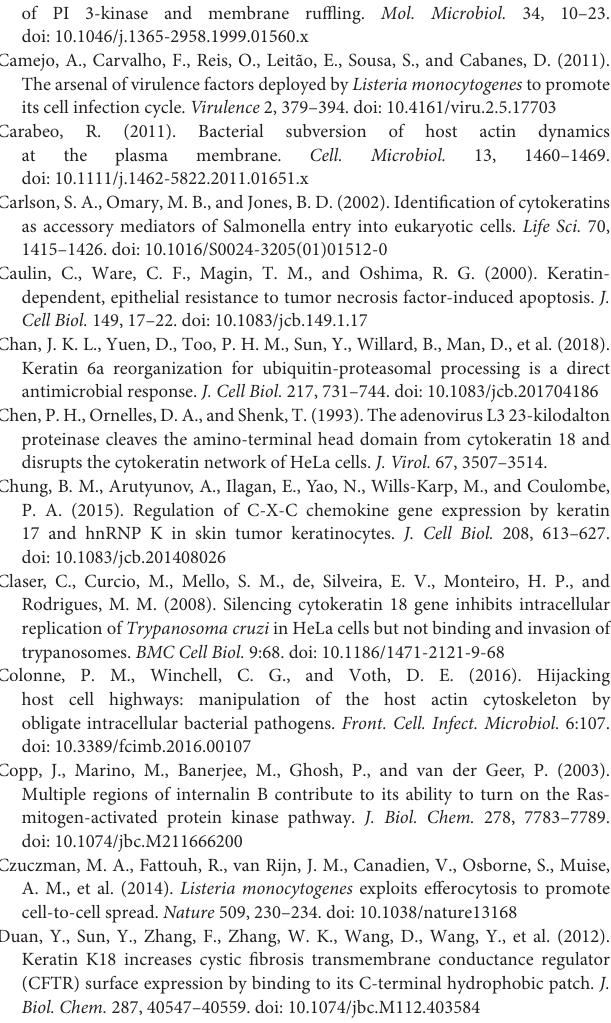
(b) Quantifications of E-cadherin, cMet, TfR and integrin β 1 in WCL and in biotinylated samples from two independent